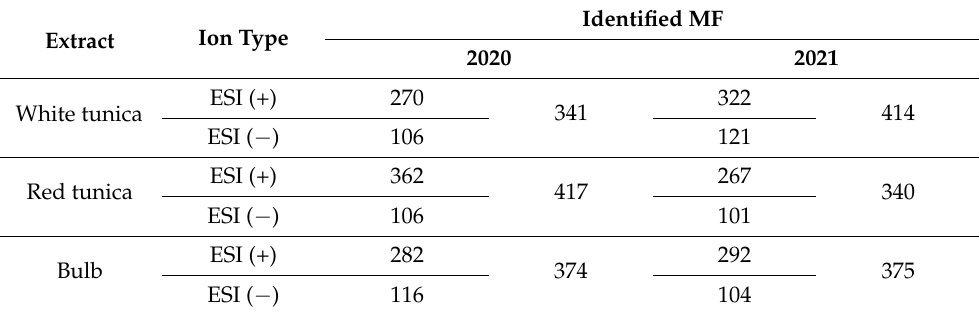
Table 2. Number of molecular formulas (MF) identified by ESI FT-ICR MS in extracts of white and red tunicae and bulb of ‘Sulmona red garlic’ collected in 2020 and 2021 a .